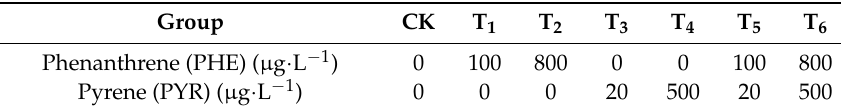
Table 1. The concentrations of PAHs in the Hoagland